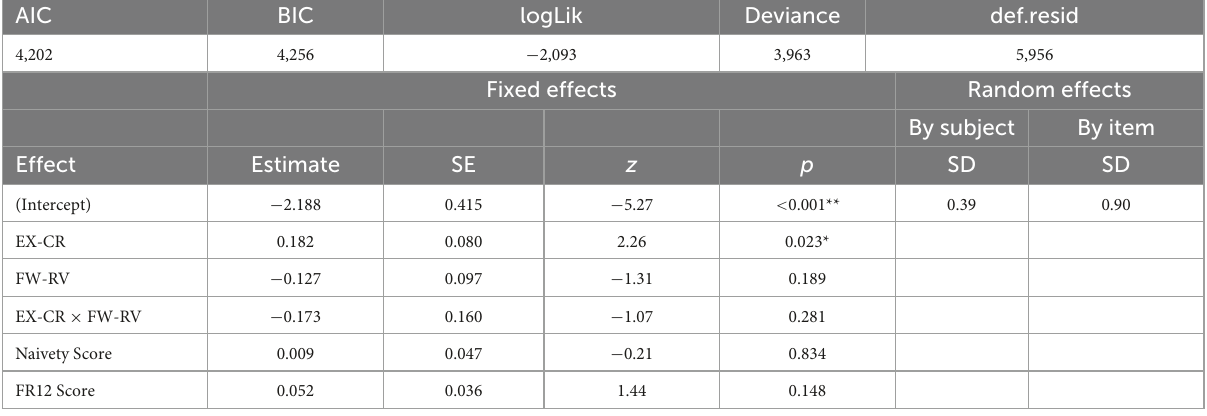
TABLE 4 Generalized linear mixed model for rebus resolution (RR) score in Experiment